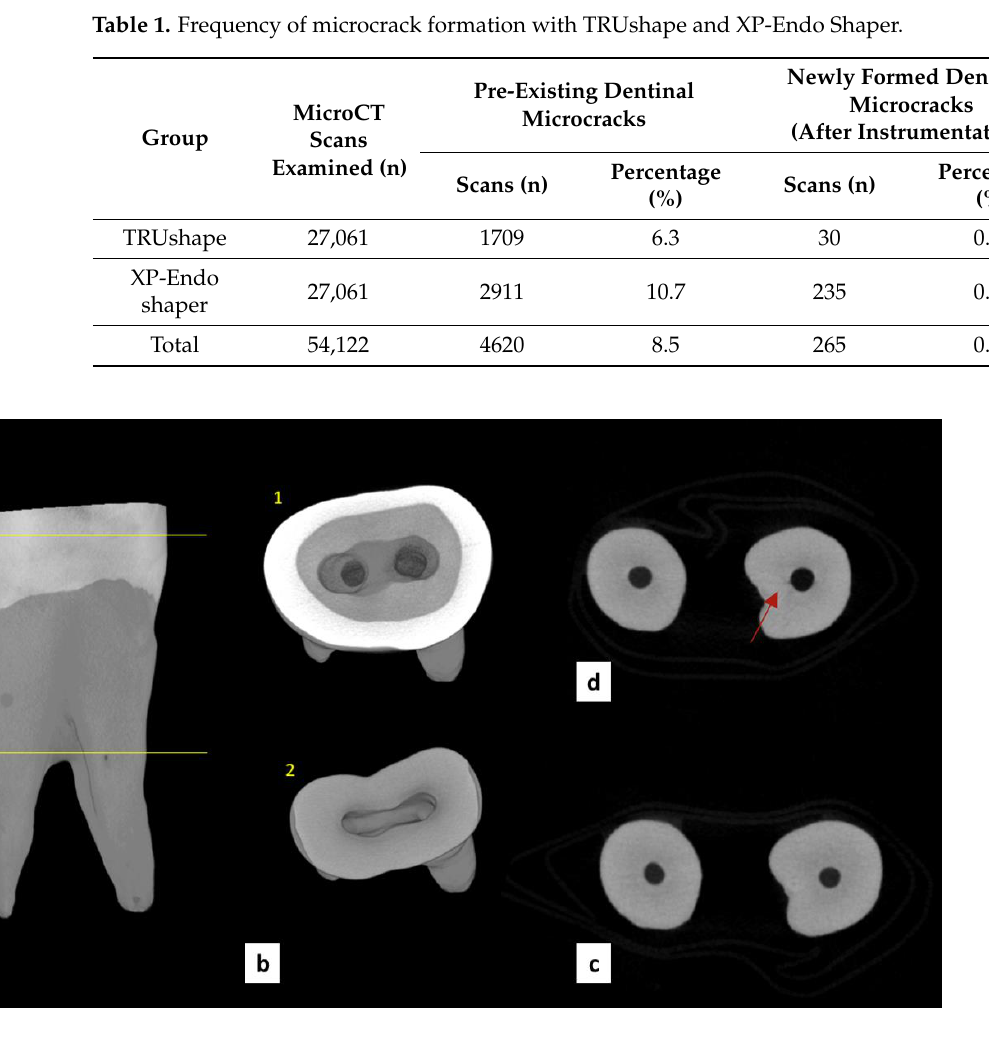
Figure 1. Three-dimensional representation of the Micro-computed tomography (MicroCT) scan of the maxillary premolar instrumented using XP-endo shaper. ( a ) Lateral view of the 3D model of the maxillary premolar. ( b ) Coronal view of the 3D model of the maxillary premolar. ( c ) Cross section of radicular canals before instrumentation. ( d ) Cross section of the canals after instrumentation with the arrow pointing at the newly formed microcrack. Table 1. Frequency of microcrack formation with TRUshape and XP-Endo Shaper.